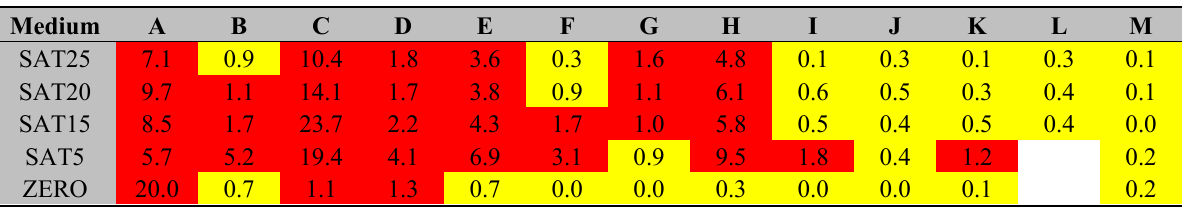
| numbers of the participants for DO measurement a . Table 6. The | E n